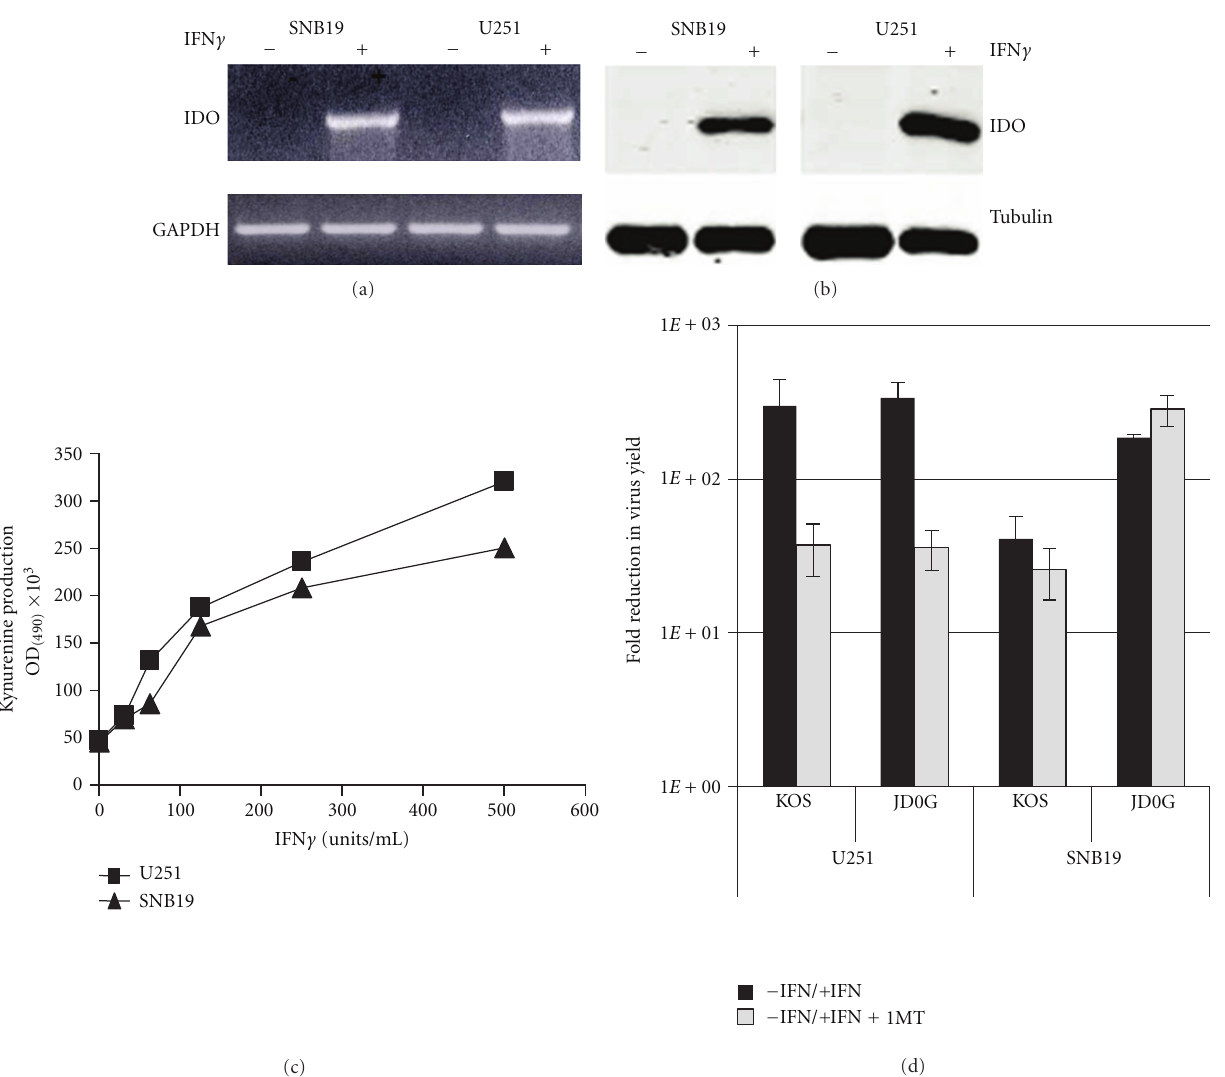
Figure 4: IFN γ -induced IDO protein has a minimal e ff ect on virus replication. (a) SNB19 or U251 cells were pretreated with varying concentrations of IFN γ (0–500U/mL) in media supplemented with 100 μ g/mL of L tryptophan. After 3 days of incubation, IDO activity was measured by determining kynurenine content in the cell supernatants. (b) U251 or SNB19 cell lines were pretreated or mock treated with IFN γ (500 U/mL) with or without 1-MT (300 μ M) 24h prior to infection with JD0G or KOS virus, and the supernatants were titered at 24hpi. The data represent the average of two independent infections, and the error bars represent the standard deviation; these data are representative of replicate